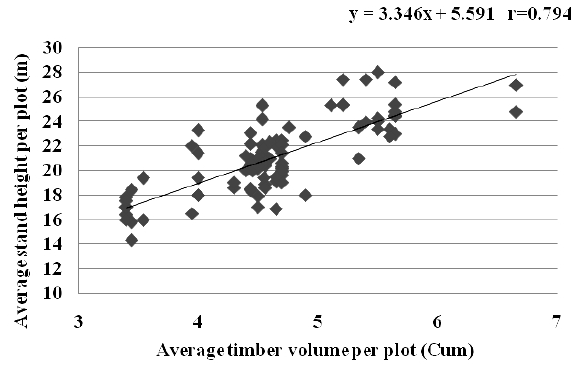
Figure 2. Relation of timber volume with tree height